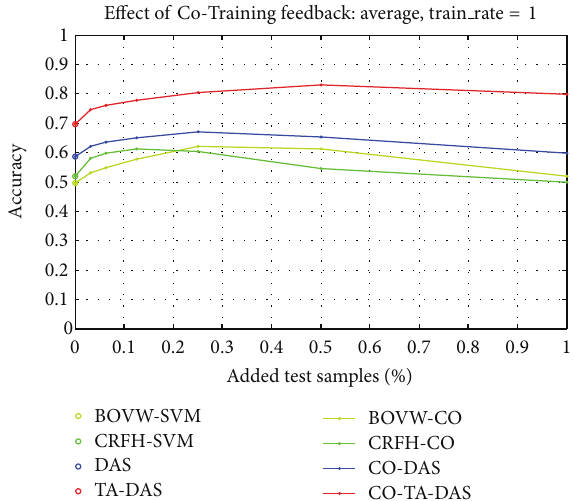
Figure 12: Comparison of the global performances for single feature (BOVW-SVM, CRFH-SVM), multiple feature late fusion (DAS), and the proposed extensions using temporal accumulation (TA- DAS) and Co-Training (CO-DAS, CO-TA-DAS). The evolution of the performances of the individual inner classifiers of the Co- Training module (BOVW-CO, CRFH-CO) is also shown. Plot of the average accuracy as a function of the amount of Co- Training feedback. The approaches without Co-Training appear as the limiting case with 0% of feedback (IDOL2 dataset, video-versus- video setup, ALL pairs).